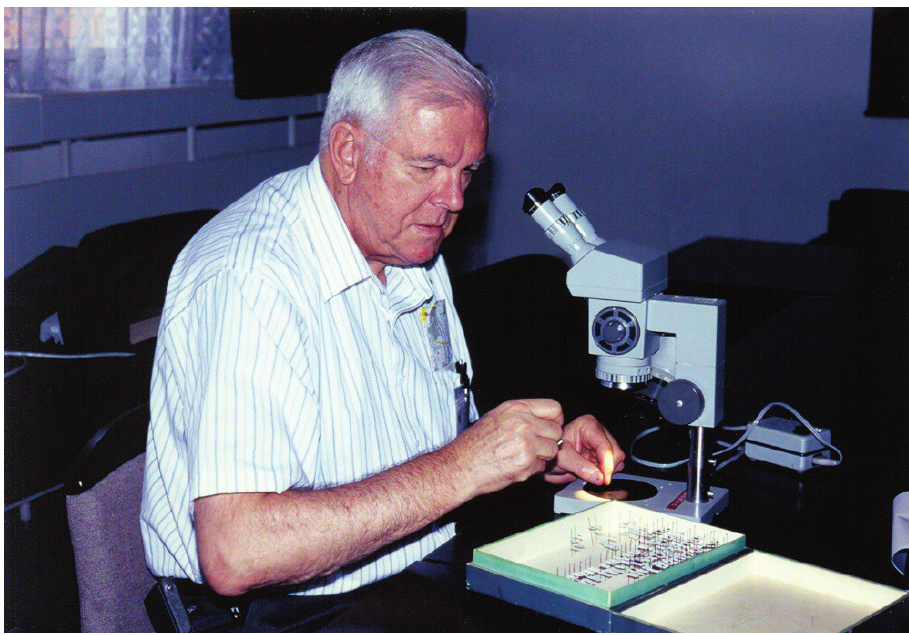
Figure 4. Stephen L. Wood at the “Bark and Timber Beetles Workshop” at the VIth European Congress of Entomology, Ceské Budejovice, Czech Republic, August 23–29,